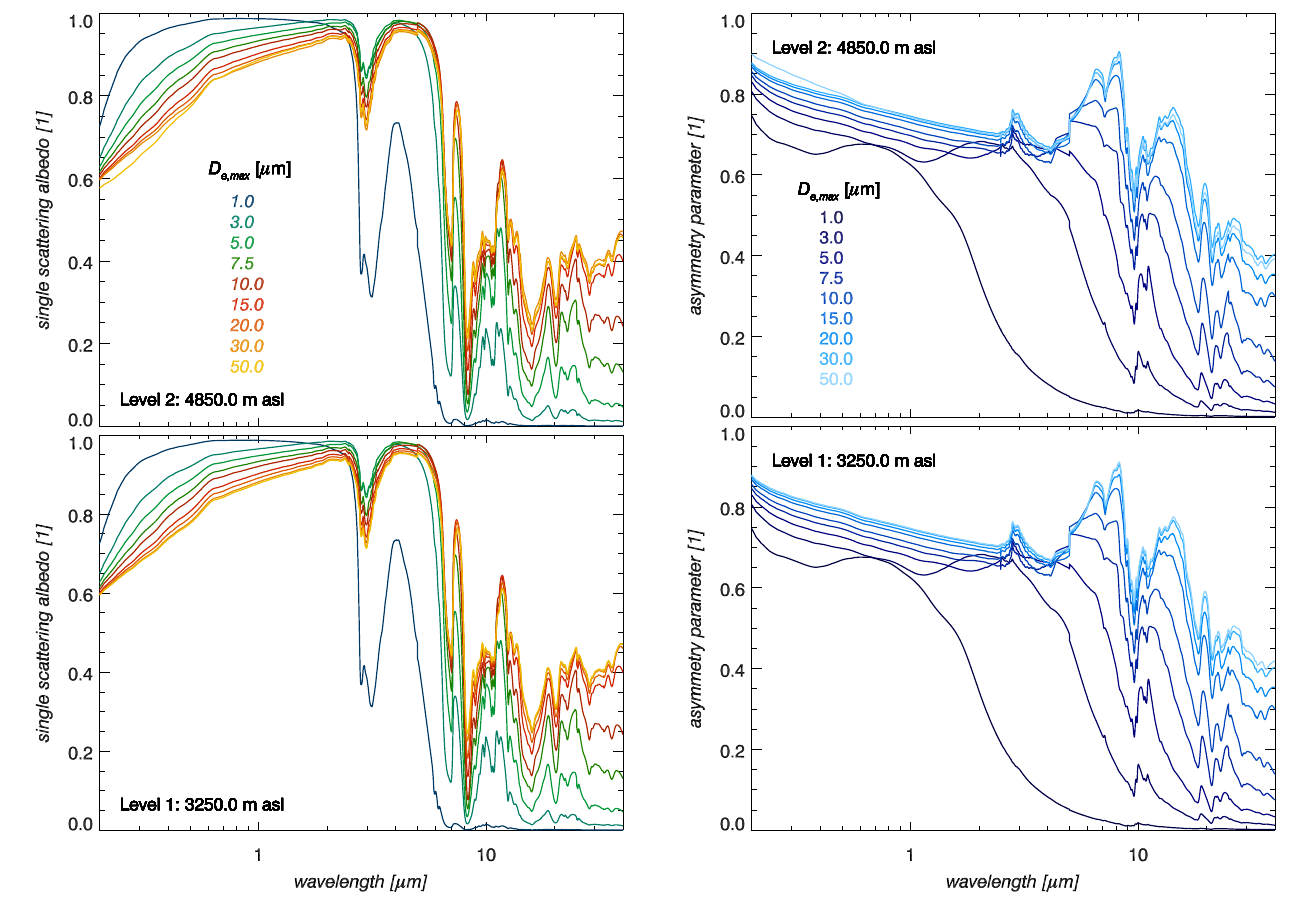
Fig. 4. Single scattering albedo of spherical Saharan mineral dust particles at the two altitude levels of the number concentration size distribution measurements, on 19 May 2006 over OZT site about noon (Weinzierl et al., 2009), as a function of wavelength. Modal parameters, which were fitted to the data, were applied for size in- tegration up to a maximum particle diameter D e , max . The coloured curves represent various values of D e , max between 1 and 50µm.